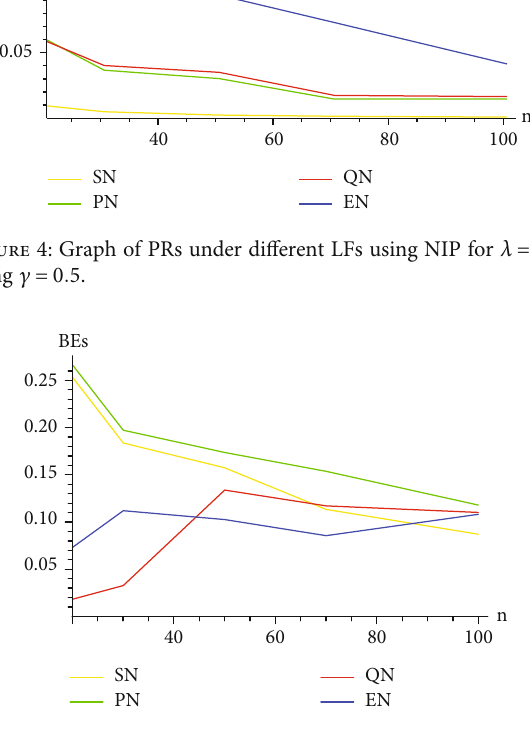
Figure 5: Graph of BEs under di ff erent LFs using NIP for γ = 0 : 1 , using λ = 0 : 5